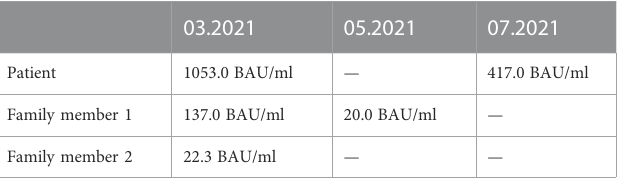
TABLE 3 Comparison of COVID-19 antibodies between the high-risk patient and the family